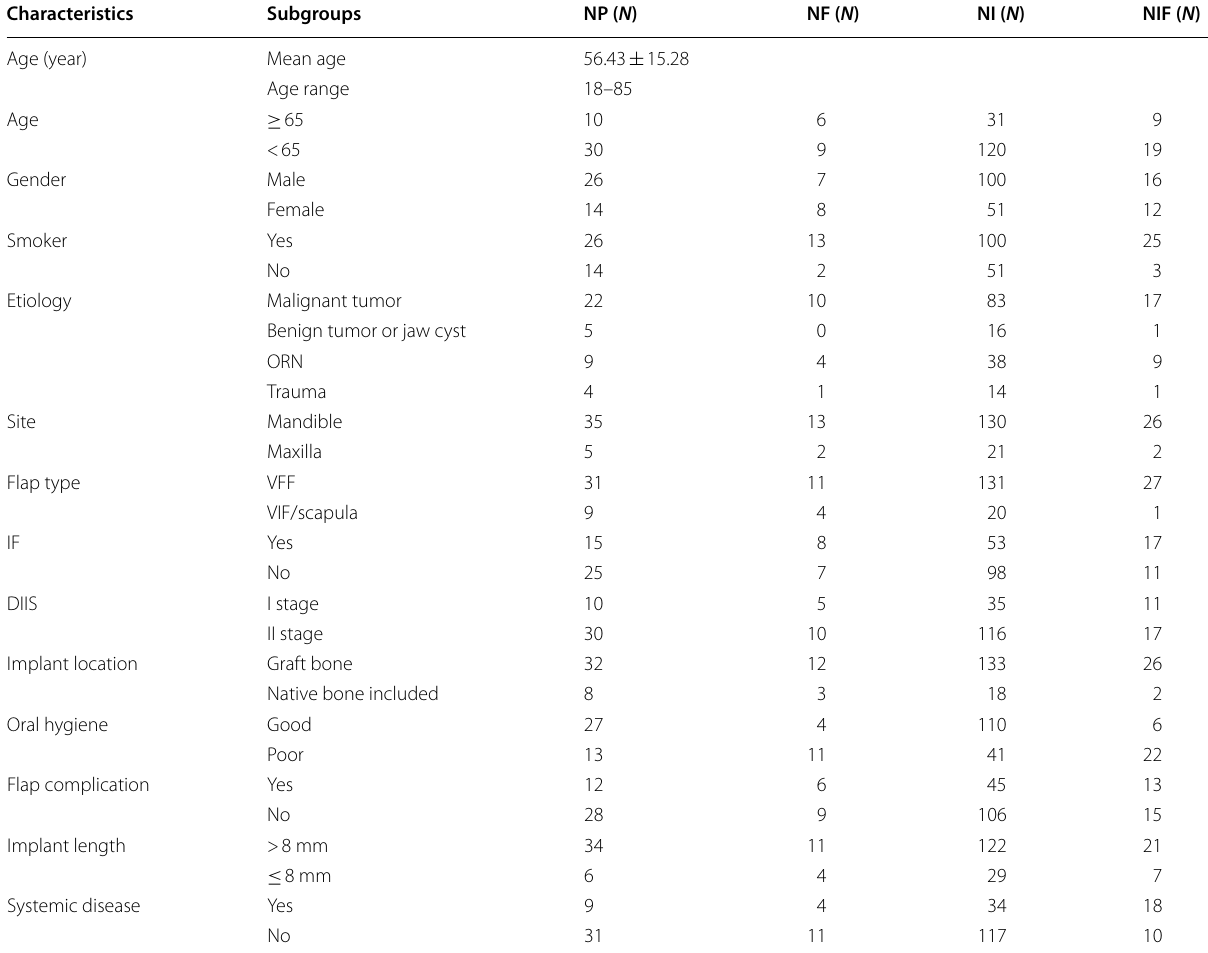
Table 1 Patient characteristics